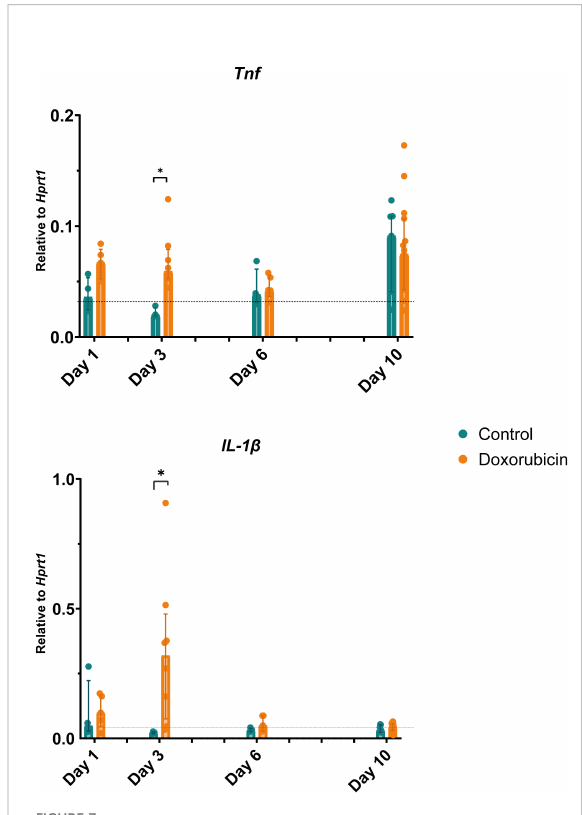
FIGURE 7 Changes in gene expression of in fl ammatory markers: tumour necrosis factor ( Tnf ) and interleukin ( Il )- 1 b . On day 3, mice in the doxorubicin-treated group had elevated levels of Tnf and Il-1 b compared to controls. Baseline, n = 6. For controls: day 1, n = 4; day 3, n = 4; day 6, n = 4: day 10, n = 7. For doxorubicin: day 1, n = 5; day 3, n = 5; day 6, n = 4; and day 10, n = 15. Data presented as scatter and bars representing the median ± interquartile range. The dotted line represents the mean of the baseline values. *p <